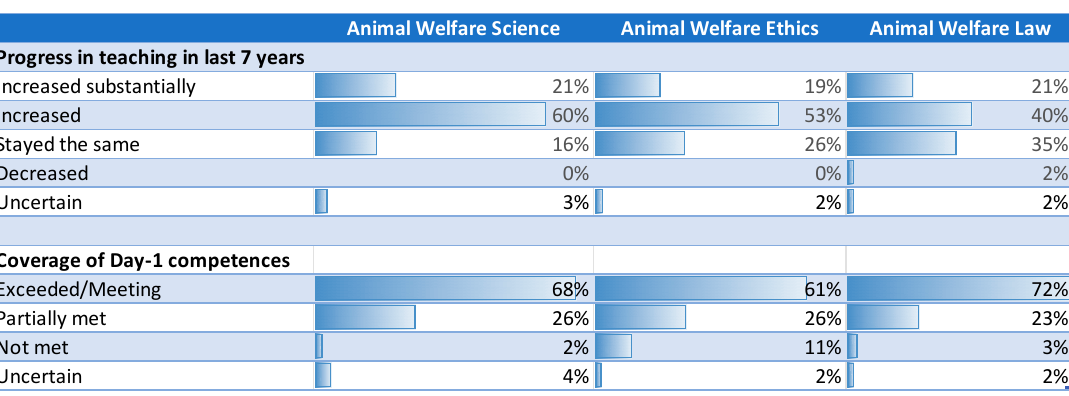
Figure 1. Progress in teaching animal welfare science, ethics and law within the last seven years (2012–2019) and percentage of European veterinary schools regarding coverage of Day-1 Competences in animal welfare science, ethics and law.